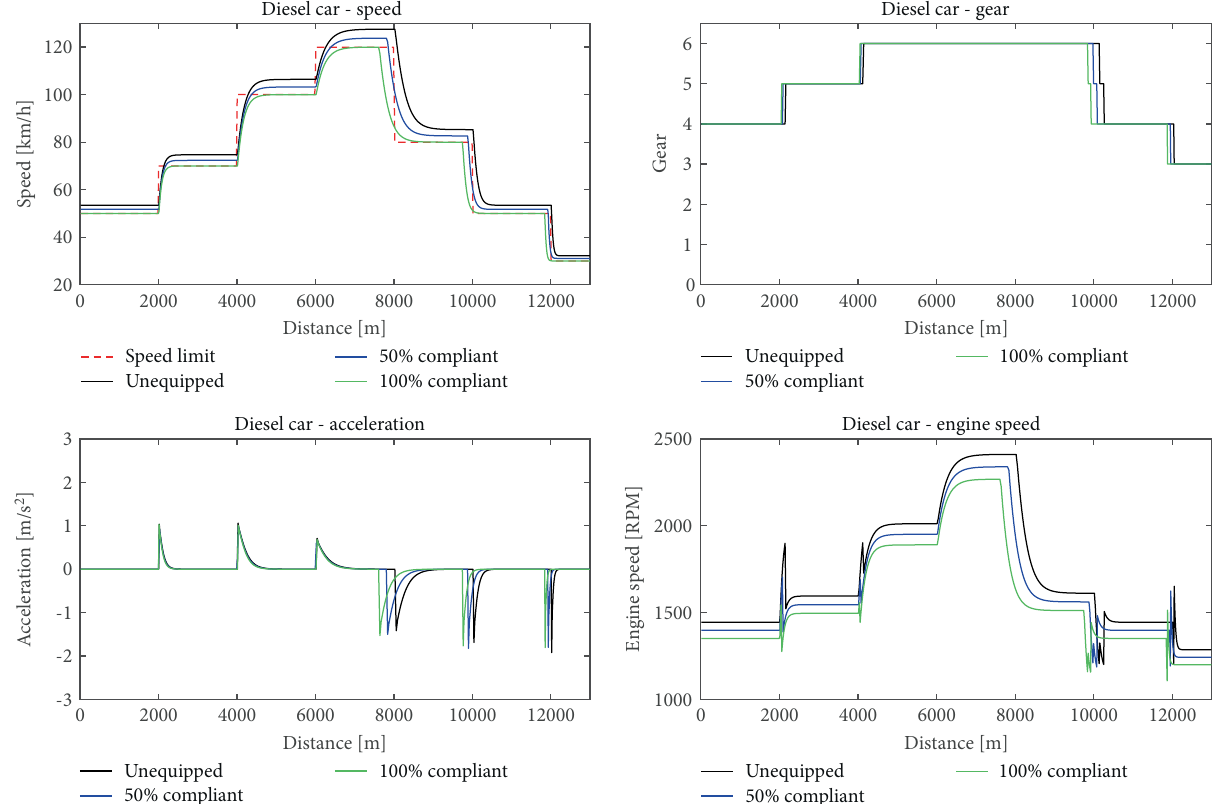
Figure 13: Simulations of a 0%, 50%, and 100% compliant driver equipped with the ecoDriver